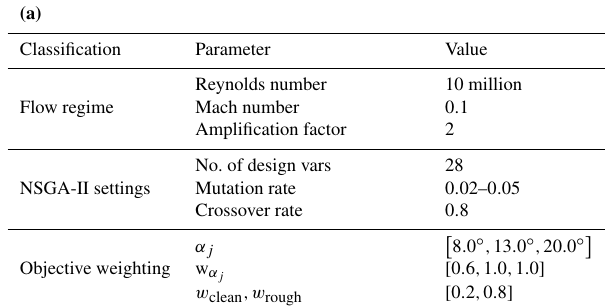
Table 2. General optimization settings (a) and optimization bound- ary conditions for the integral slat design (b)